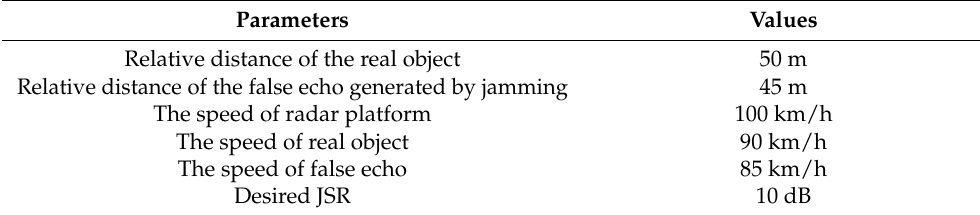
Table 3. Scenario parameters for RDM and 2D-CFAR detection.